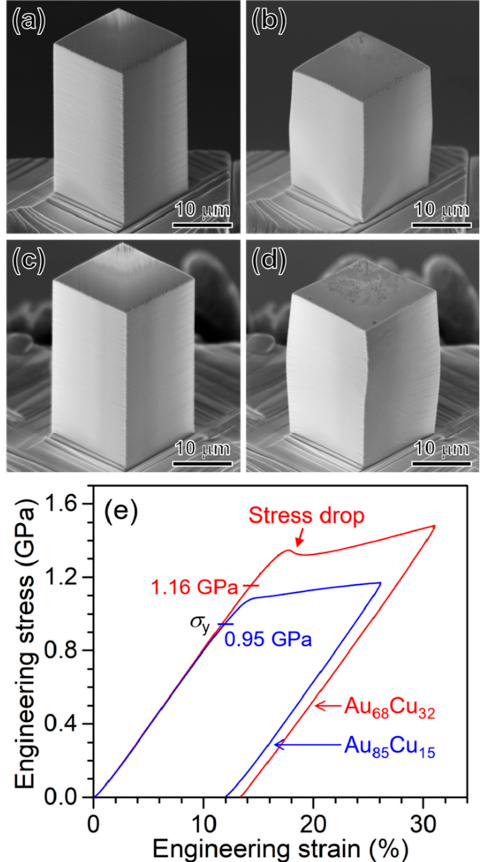
Figure 2. SEM images of ( a , b ) Au 85 Cu 15 and ( c , d ) Au 68 Cu 32 micro-pillars ( a , c ) before and ( b , d ) after the compression with 12%–14% strain. ( e ) Engineering stress–strain curves obtained from the micro-compression tests.